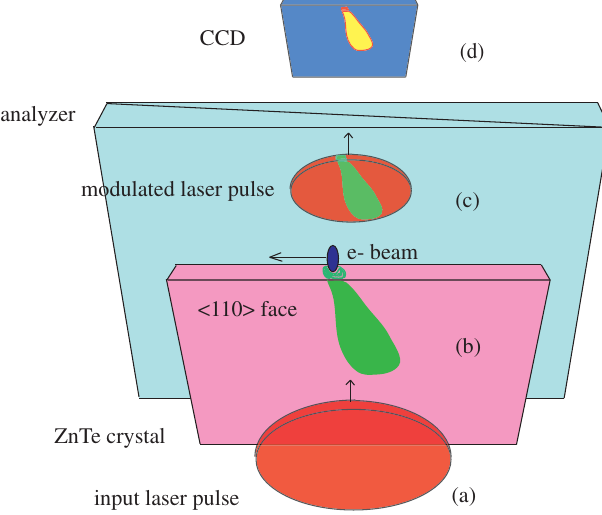
FIG. 3. (Color) Top-down/frontal view showing single-shot EOS 2D geometry. (a) A linearly polarized laser pulse approaches. The half-wave plate and the polarizer used to control the polarization direction are not shown. (b) An e- bunch induces birefringence in the ZnTe crystal. (c) The e- bunch profile is imprinted on the laser pulse as a phase modulation. (d) The analyzer removes all but the modulated part of laser, which is detected on the CCD.